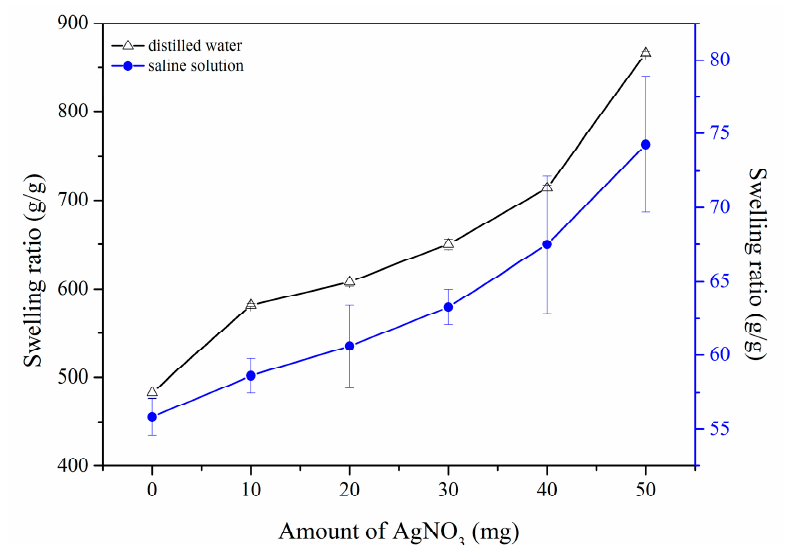
Figure 1. Swelling behavior in distilled water and 0.9 wt % NaCl solution of the superabsorbent polymer